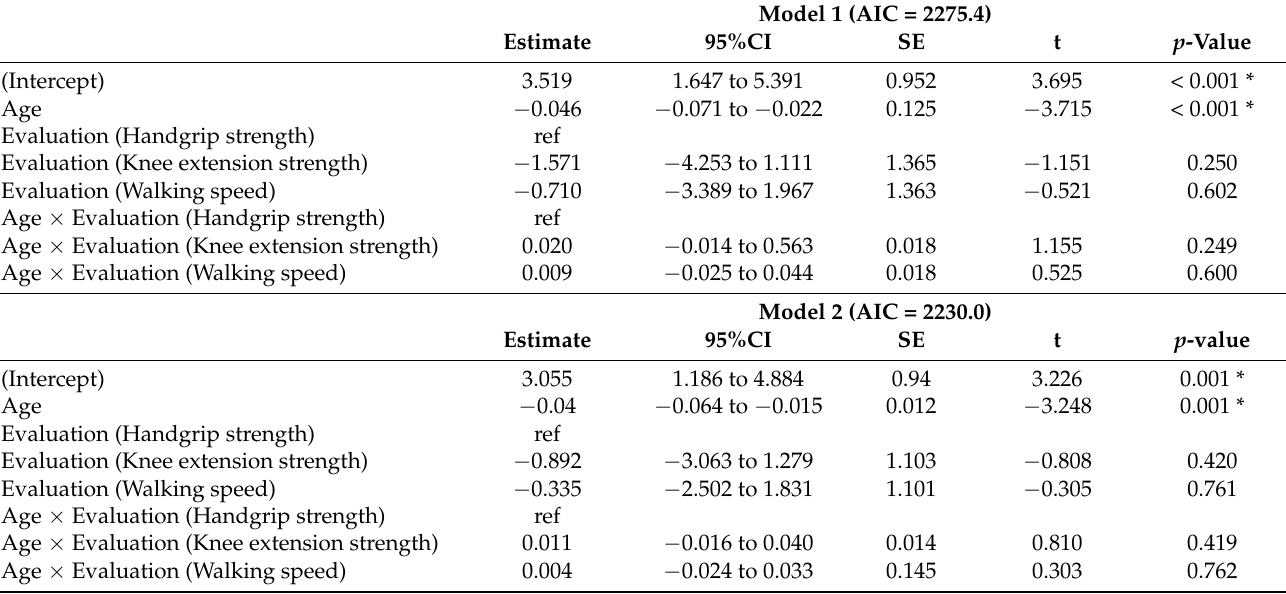
Table 2. Linear mixed-effects model of the association between age and measures of physical function and the interaction effects in